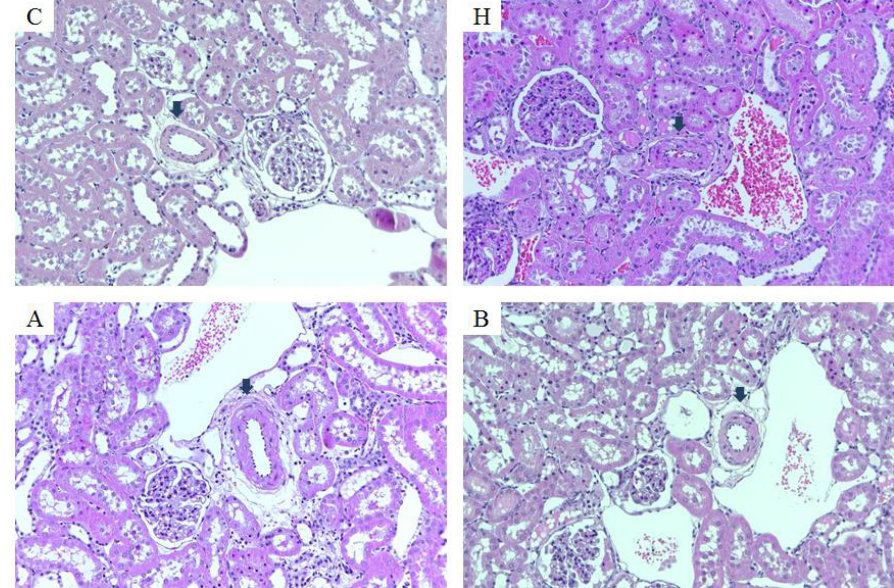
Figure 2. Pathohistological changes in the kidney of rats at the end of the study. C, control group; H, hypertensive group; A, 20 mg/kg/day antroquinonol group; and B, 40 mg/kg/day antroquinonol group. Group C showed normal intrarenal arterioles. Group H had prominent intimal thickening with a reduced vascular lumen, while group A had mild to moderate thickening of the arterioles, and group B (25 mg/kg/day of L-NAME with 40 mg/kg/day antroquinonol in the diet) showed mild thickening of the arterioles. (H & E stain, original magnification × 200).